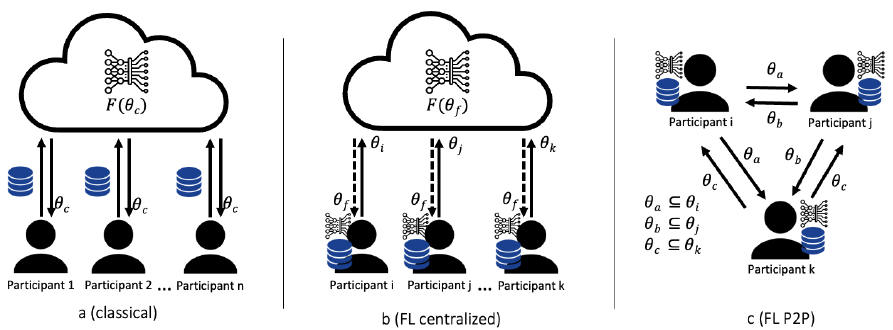
Figure 1. Comparison between classical centralized ML approach and centralized or P2P